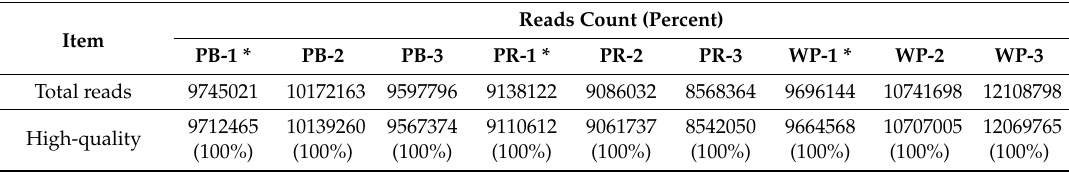
Table 1. Summary of the sequencing data from red